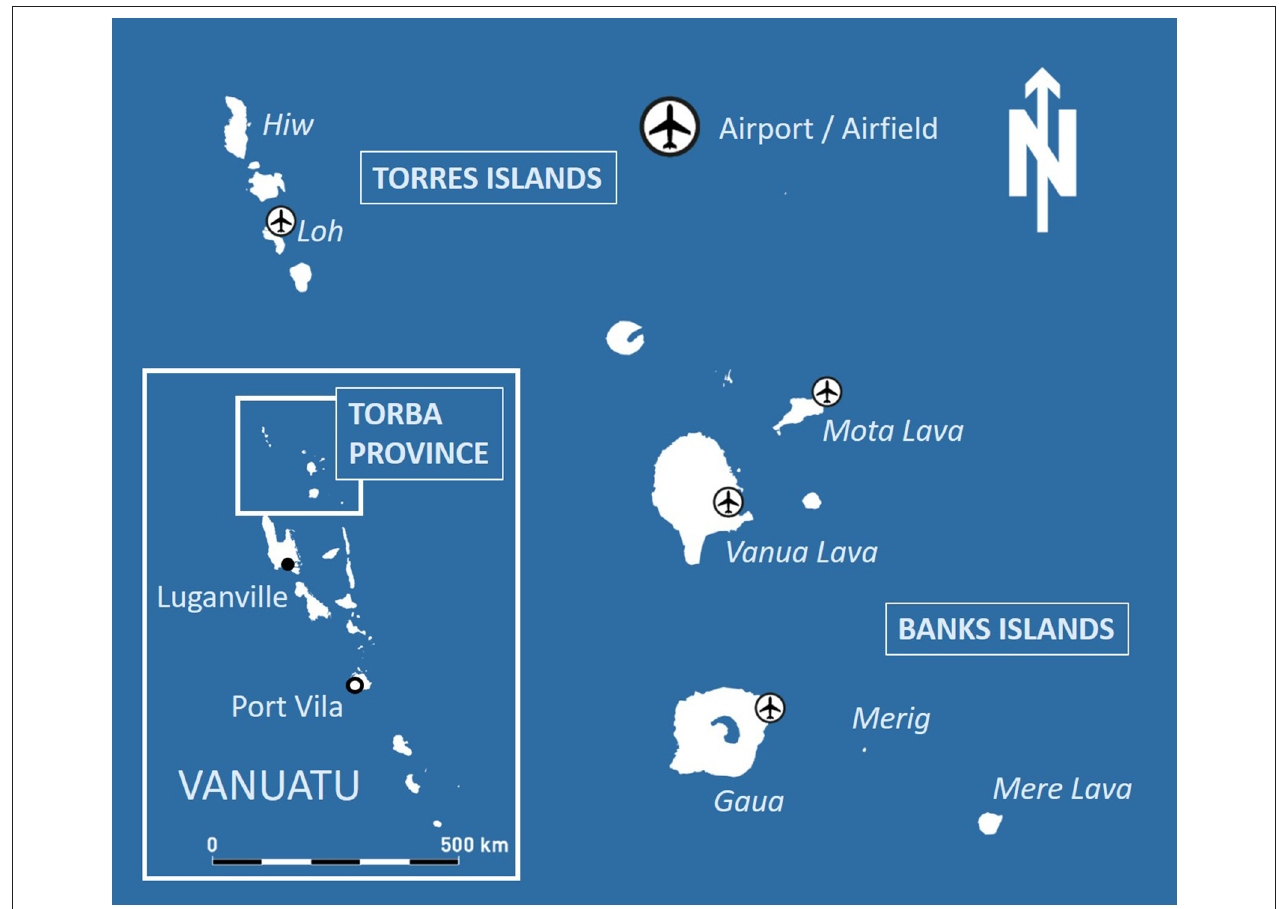
FIGURE 2 | Map of study are with islands where interviews, workshops, and participant observation took place.